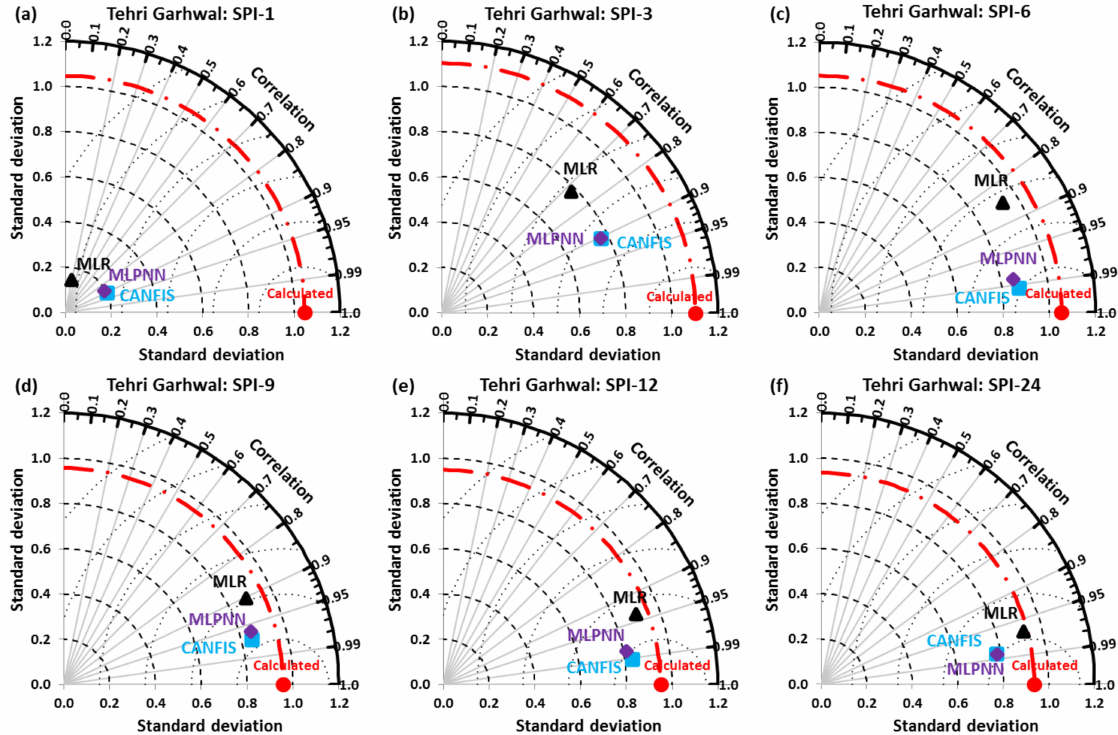
Figure 16. ( a – f ) Taylor diagram of predicted and calculated multi-scalar SPI at Tehri Garhwal